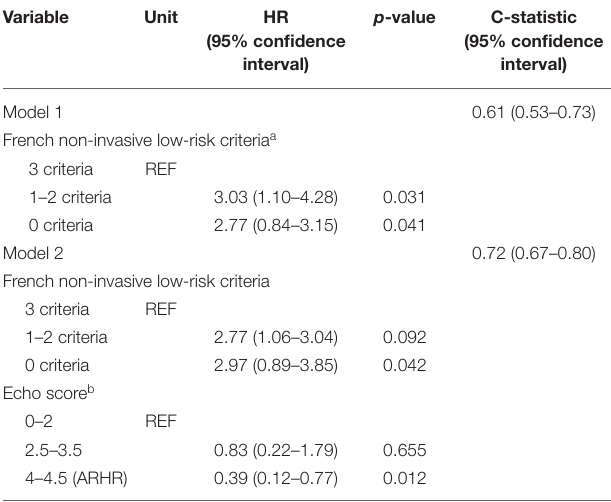
FIGURE 5 | Survival estimates of patients with and without attenuated right heart remodeling (ARHR). Green line (echo score, 4.0–4,5) represents the survival of patients with ARHR; blue line (echo score, < 4.0) represents the survival of patients without ARHR. TABLE 4 | Cox regression models for dead prediction according to the French non-invasive risk assessment and